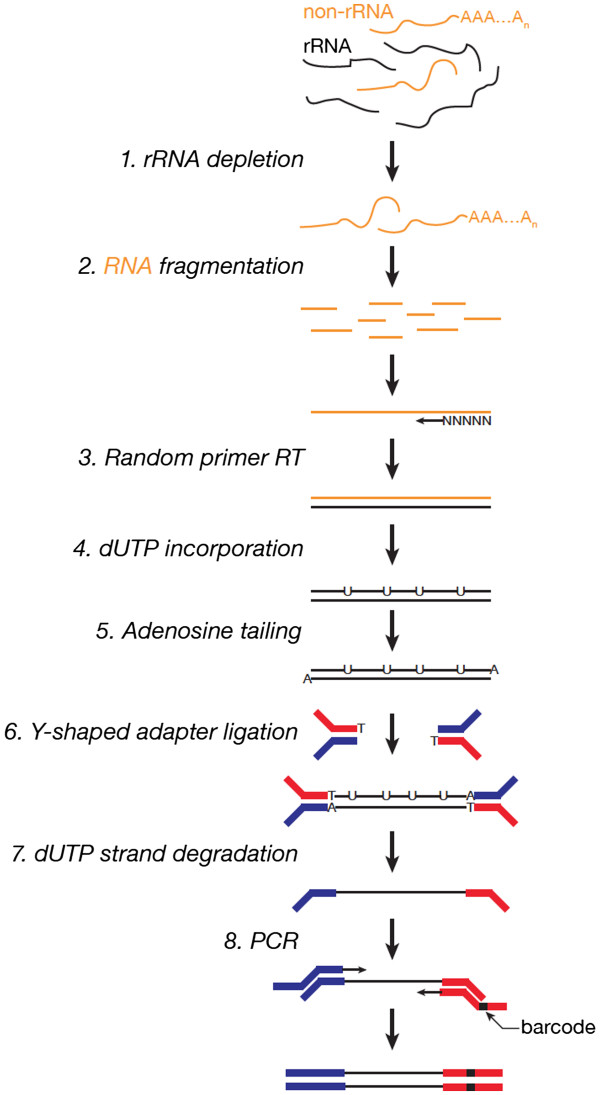
Protocol workflow.